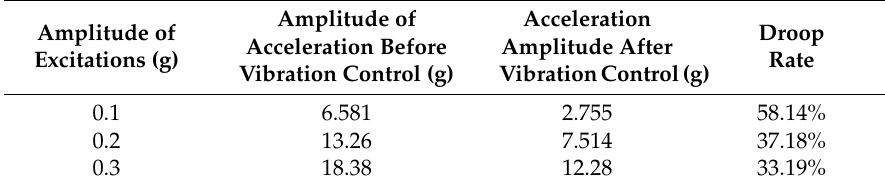
Figure 19. Vibration response in the ( a ) time domain and ( b ) frequency domain under excitation of 0.3 g. Table 6. Amplitude of the acceleration response under different excitations.